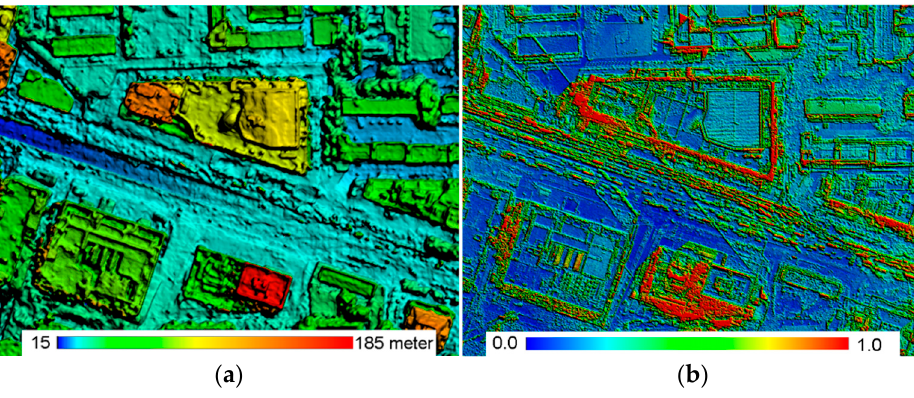
Figure 7. DSM and matching cost map without handling occlusion: ( a ) DSM with high buildings where the elevation from large to small is render from red to blue; and ( b ) matching cost map where the matching cost from high to low is rendered from red to blue.